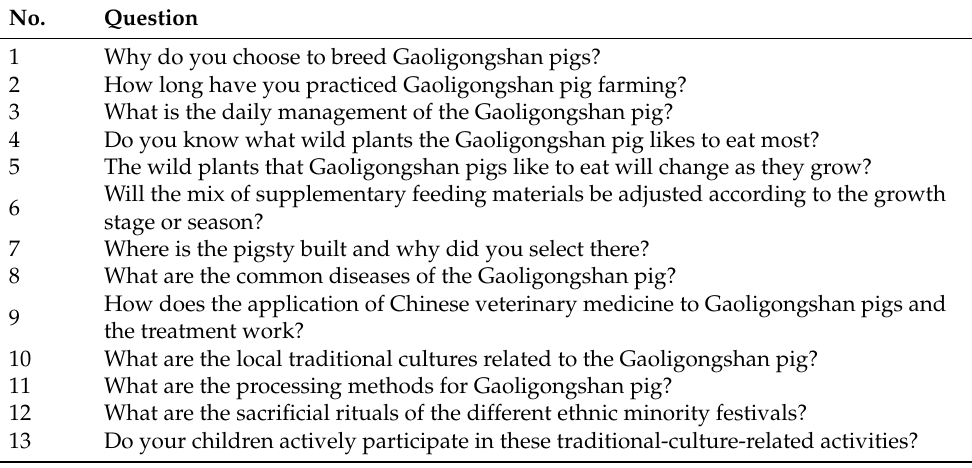
Table 1. Questions used for semi-structured interviews.